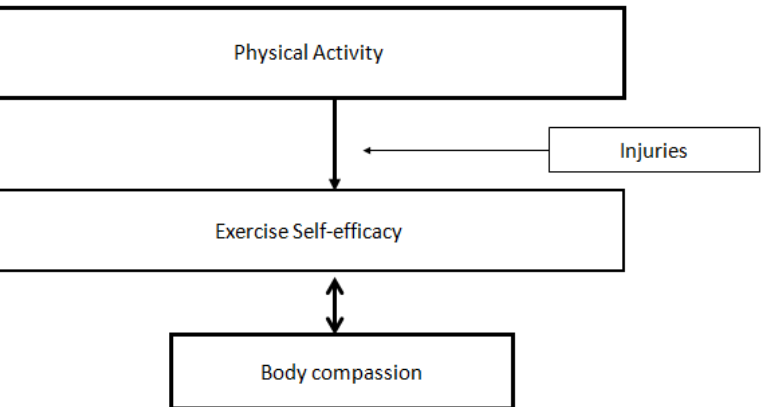
Figure 5. The Relationship between Exercise Self-efficacy and Body Compassion. Note. This figure indicated the path from physical activity to body compassion, which it is in lined with the EXSEM, with the replacement of body compassion. However, injuries is indicated as a possible mediator between physical activity and exercise self-efficacy, in order to reach body compassion. Besides, the relationship between exercise self-efficacy and body compassion could be indicated as inter-related.